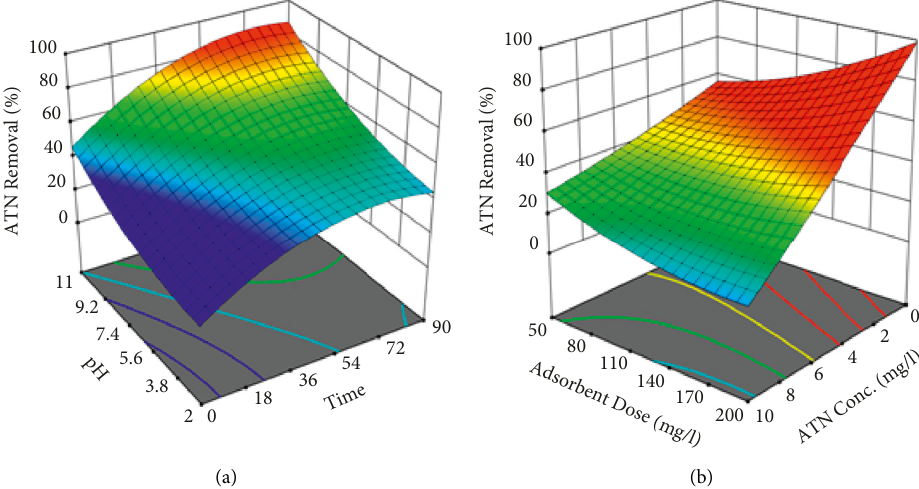
Figure 2: Relation between atenolol removal efficiency and the interaction terms by 3D plot: (a) interaction between pH time; (b) in- teraction between atenolol concentration-adsorbent